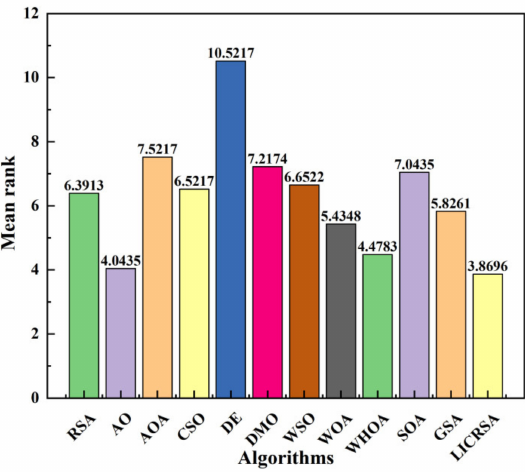
Figure 5. Mean rank of different